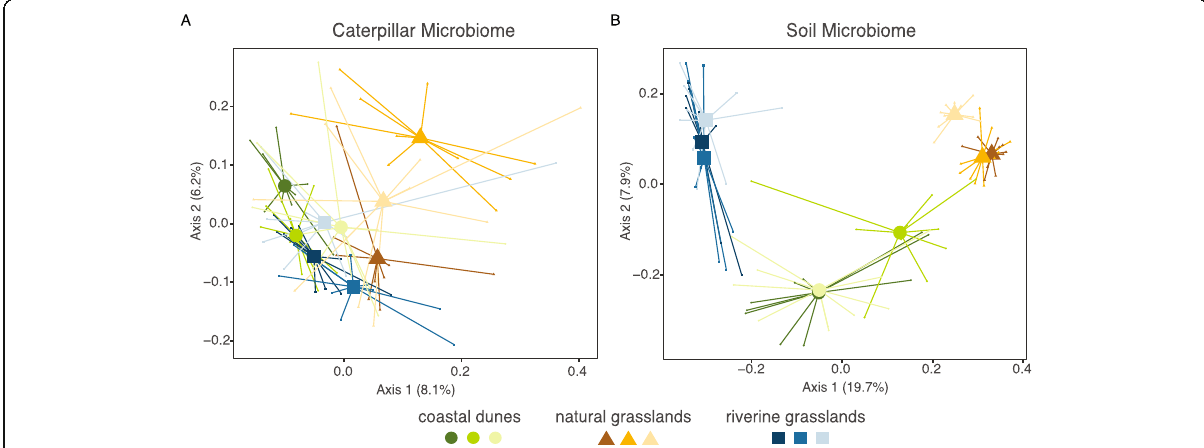
Fig. 4 Microbiome community composition of caterpillars ( a ) and soil ( b ) represented by Principal Coordinates Analysis calculated with Bray- Curtis dissimilarities, with ASVs present in at least three samples and being highly abundant ( ≥ 0.1%). Percentage of variance explained by the axes is indicated between